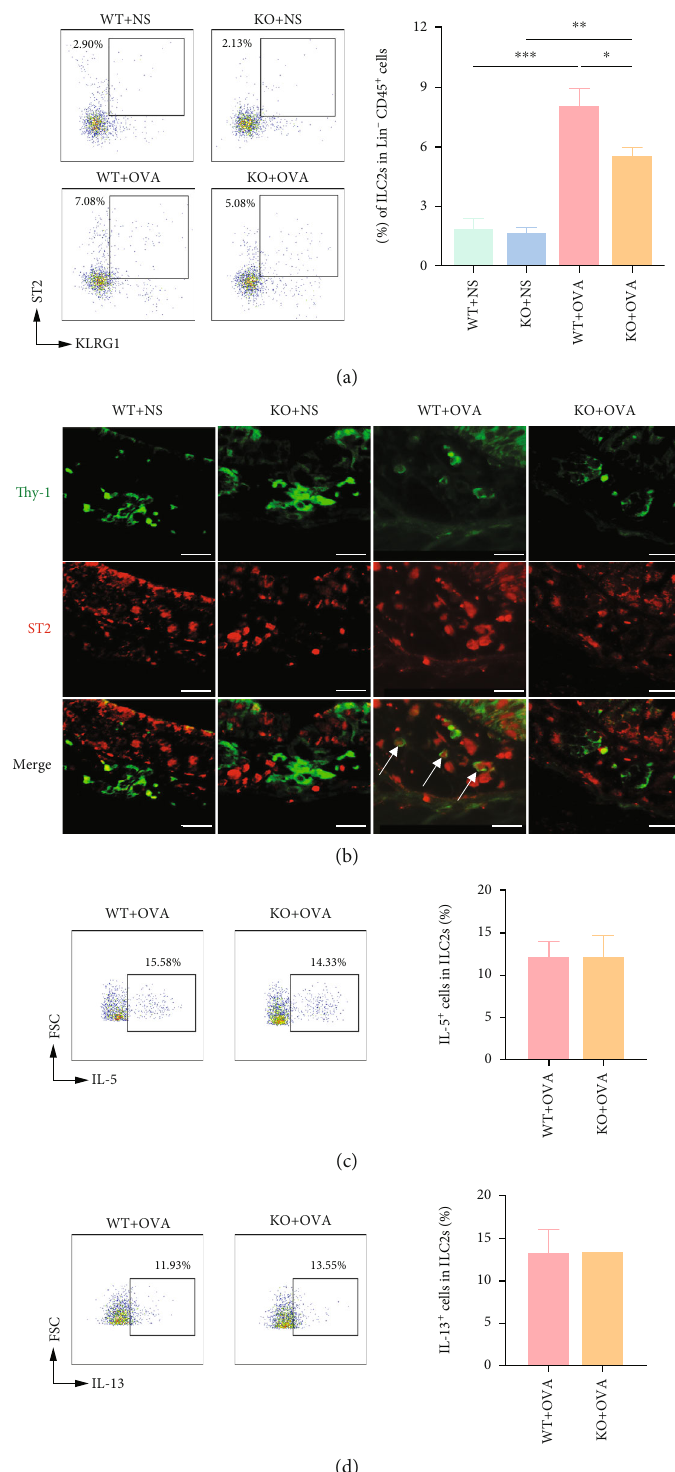
Figure 5: CD226 de fi ciency reduced the proportion of ILC2 in the nasal mucosa in AR. (a) Mononuclear cells were isolated from the nasal mucosa of WT and Cd226 KO mice. The proportion of ILC2s (Lin − CD45 + ST2 + KLRG1 + ) among Lin − CD45 + cells ( n = 3 ). (b) Representative images of immuno fl uorescence staining with ST2 and Thy-1 antibodies. ILC2s were positively stained for both ST2 and Thy-1. The white arrows represent ILC2s. Each experiment was repeated three independent times. Scale bar = 25 μ m. (c, d) The proportions of (c) IL-5 + and (d) IL-13 + cells in ILC2s ( n = 3 ). AR: allergic rhinitis; OVA: ovalbumin; NS: normal saline; ILC2s: type 2 innate lymphoid cells; WT: wild type; KO: knockout. ∗ P < 0 : 05 , ∗∗ P < 0 : 01 , and ∗∗∗ P < 0 : 001